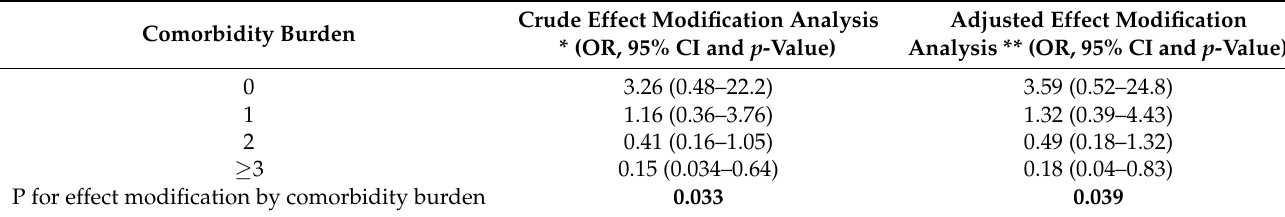
Table 4. Logistic regression analysis to examine the effect modification by the comorbidity burden on the effectiveness of vitamin D on the study